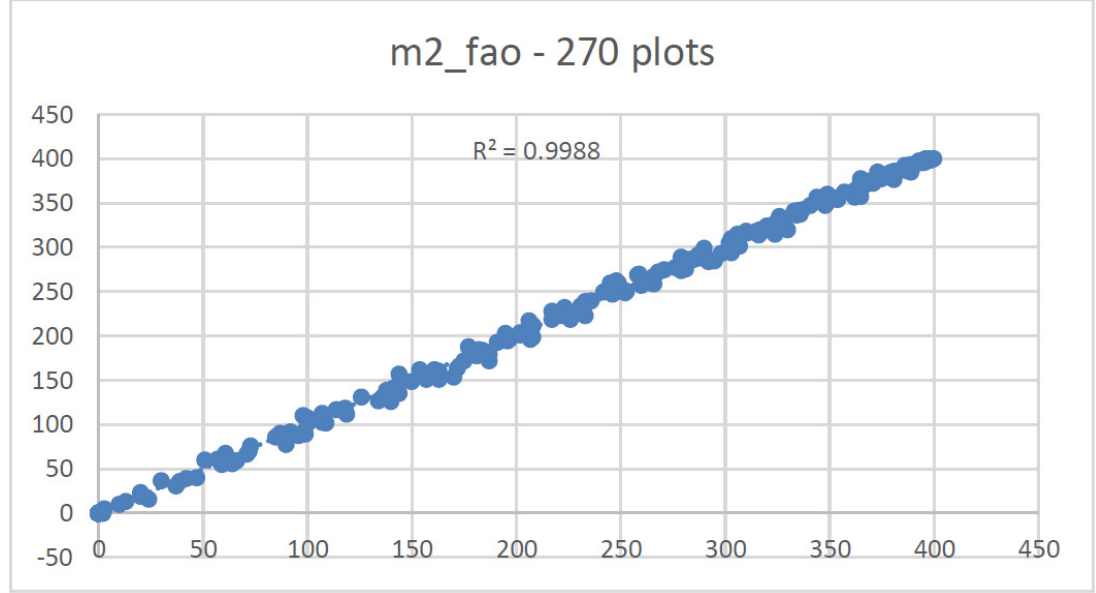
Figure A8. The reference area compared to the estimated forest area according to Method 2 for test plots (10 × 10 m 2 ) as defined by FAO/UN.